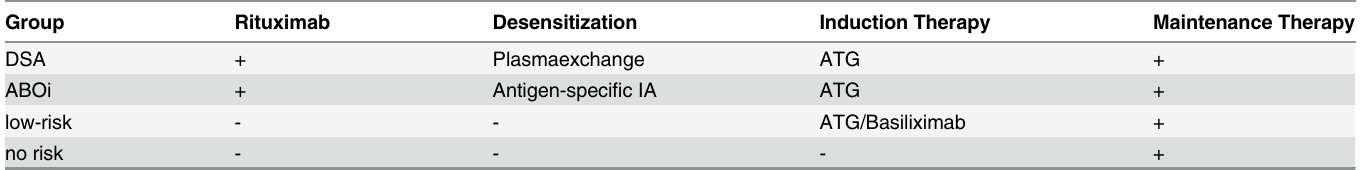
Table 1. Protocols for desensitization and immunosuppressiv therapy.